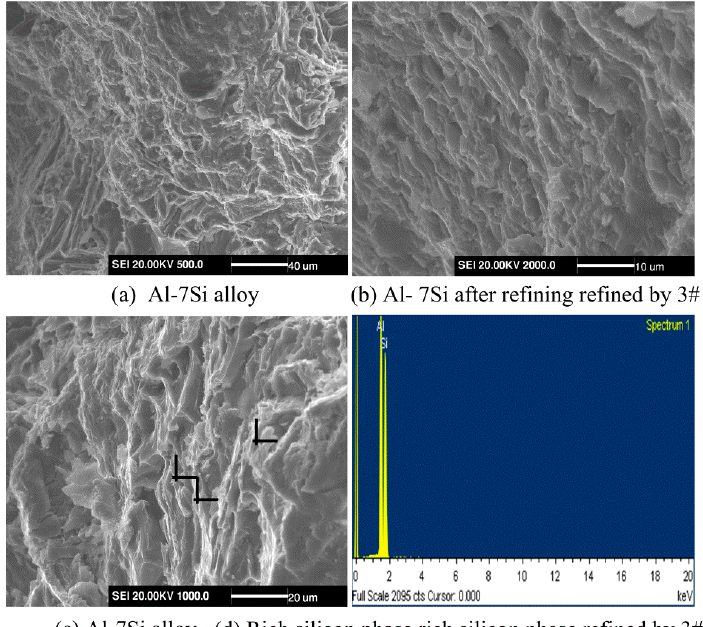
Figure 13. Fracture analysis of Al–7Si alloy after refining by Al–Ti–2(Mg–30%Ce).